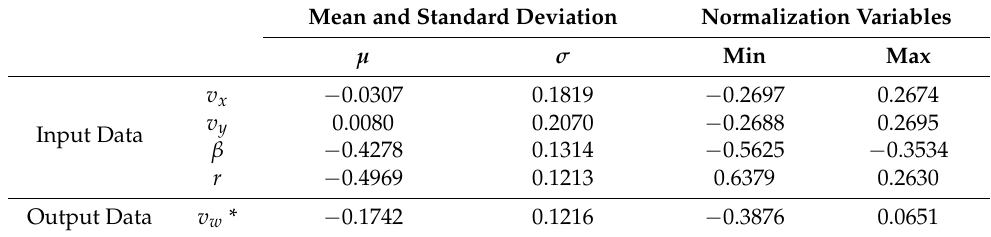
Table 3. Training data for steering (longitudinal) control.